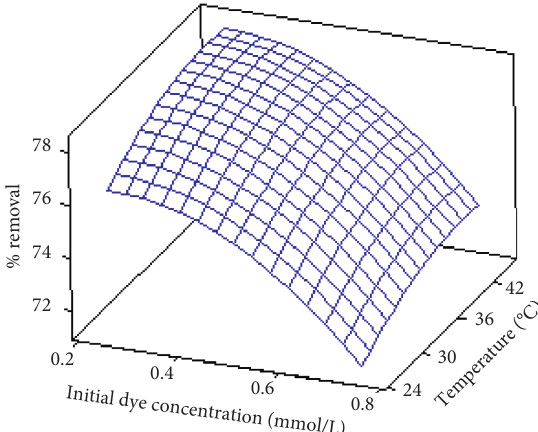
Figure 5: Effect of initial dye concentration (mmol/L) and temperature ( o